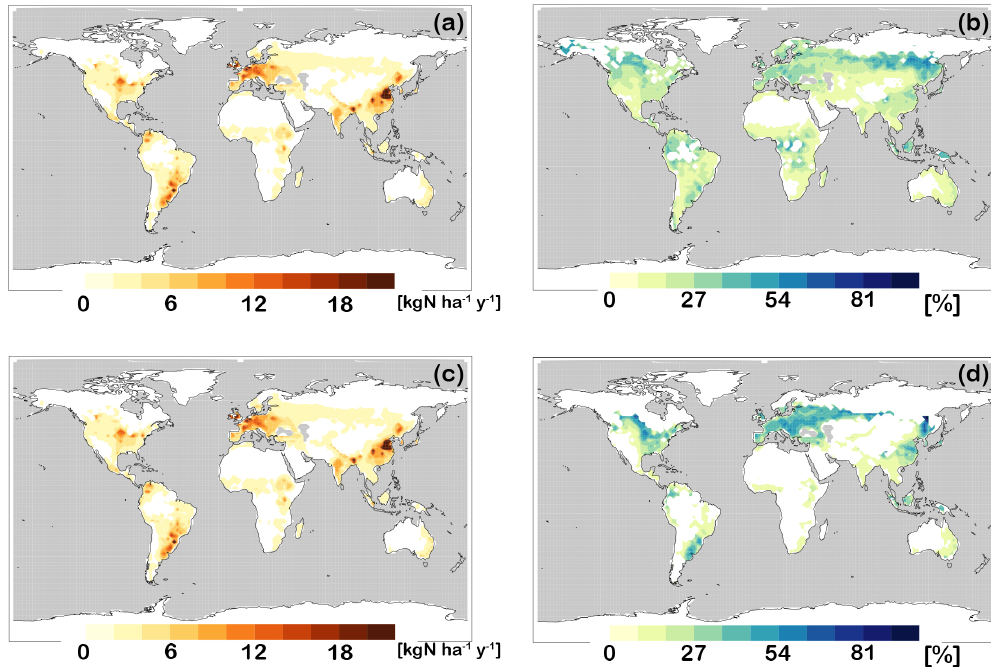
Figure 8. As in Fig. 6 but for flux of TAN nitrogen to the